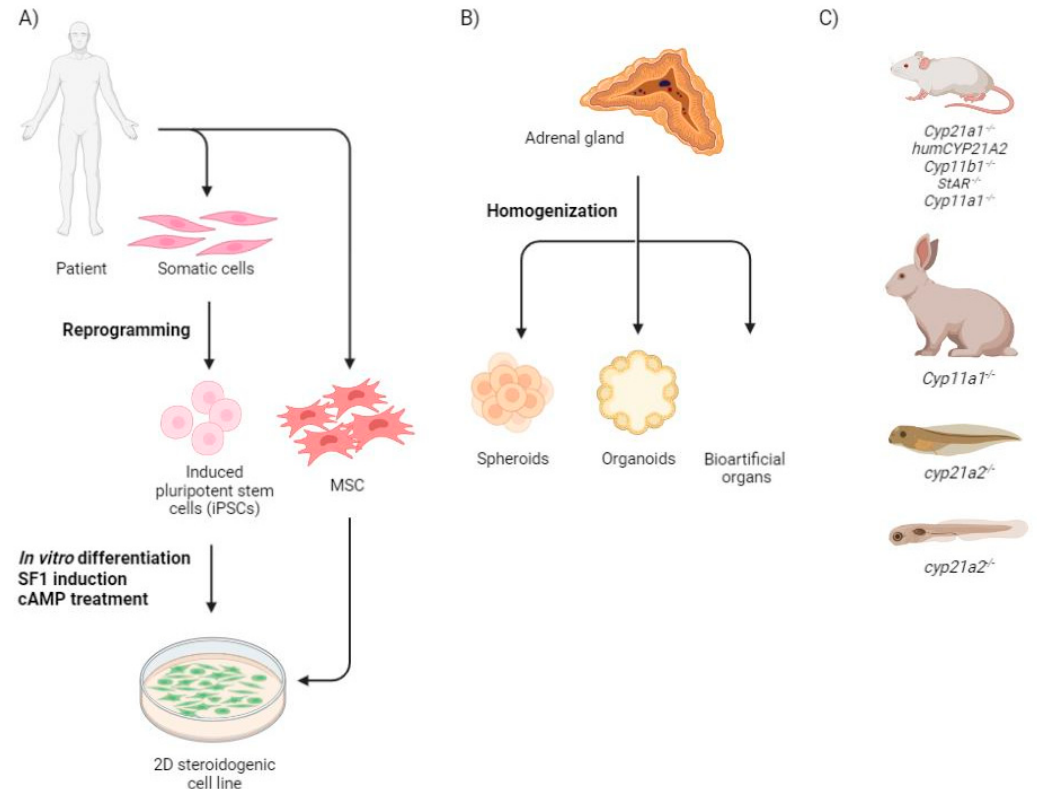
Figure 2. The main types of the CAH models. ( A ) Monolayer patient-specific differentiated cell cultures; ( B ) 3D structures from homogenized organ; ( C ) Genome modified animals (top down): five different mouse models with modified steroidogenic genes, rabbit Cyp11a1 knock-out model, Xenopus tropicalis tadpole and zebrafish larva cyp21a2 deficiency models. MSC–mesenchymal stromal cells: SF1–steroidogenic factor 1; dbcAMP–dibutyryl cyclic adenosine monophosphate; ECM–extracellular matrix; KO–knock-out. Created with